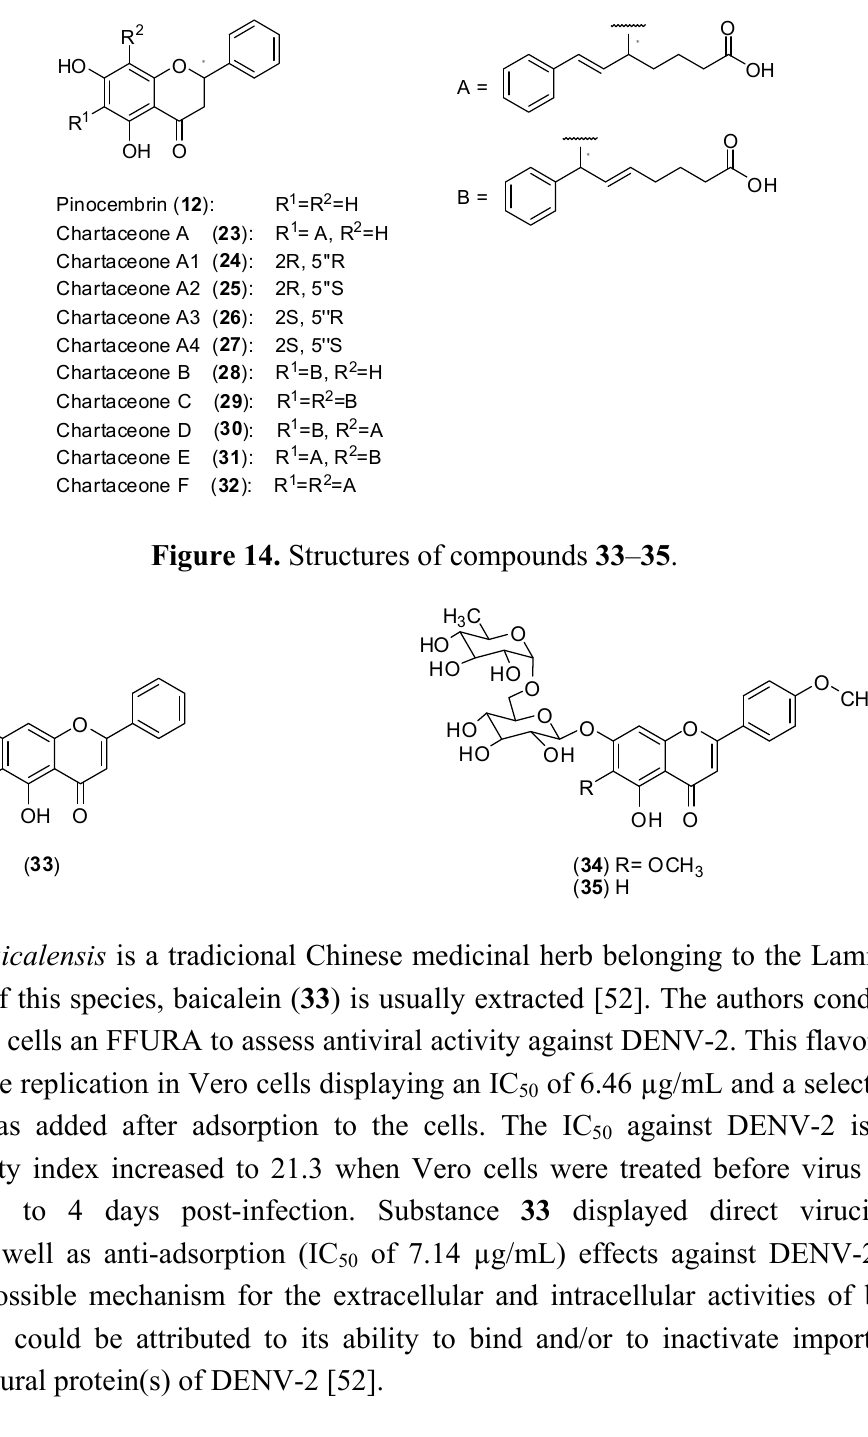
Figure 13. Structures of pinocembrin and chartaceones.